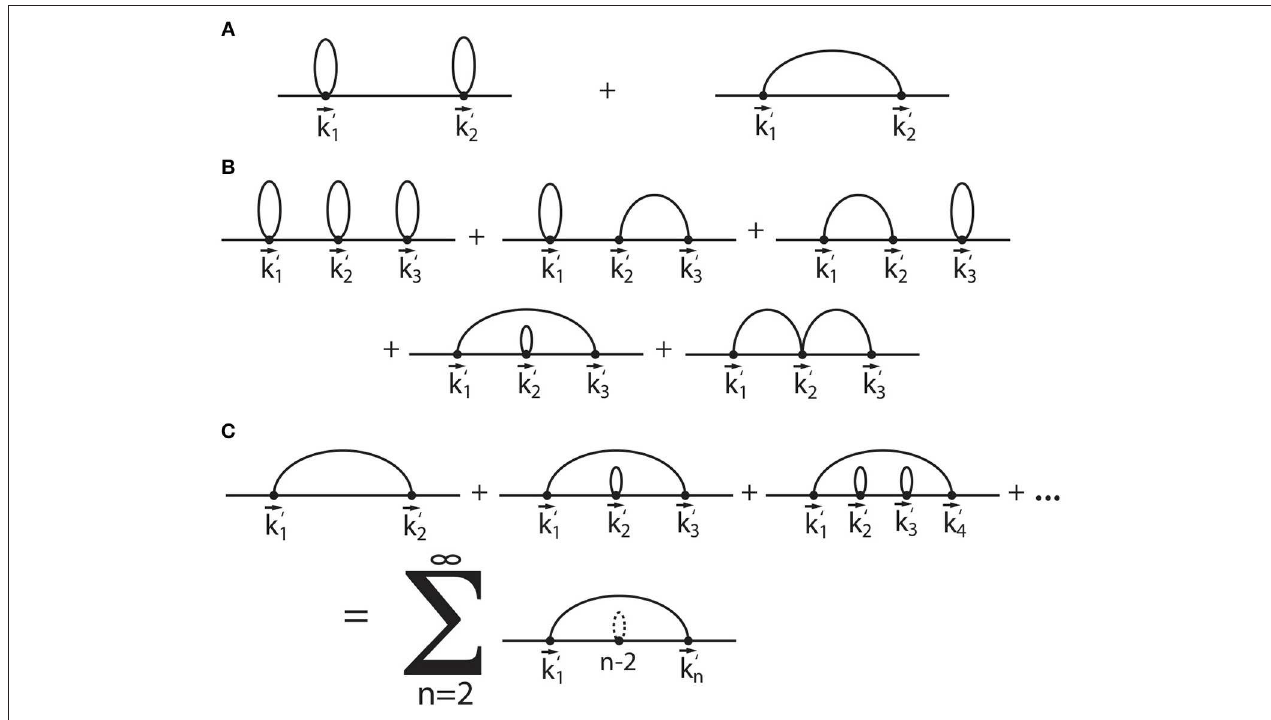
s ) (Equation 13). The ; i D D 3 . The infinite sum of diagrams found in h i D